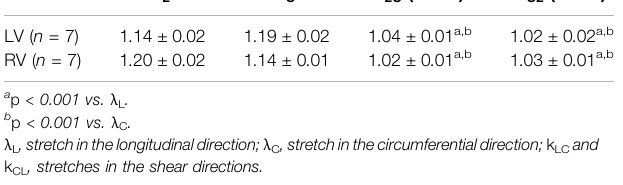
TABLE 1 | Maximum stretches in the in-plane and shear directions during equibiaxial tests. Data are presented as mean ± SEM. Ventricle λ L λ C k LC